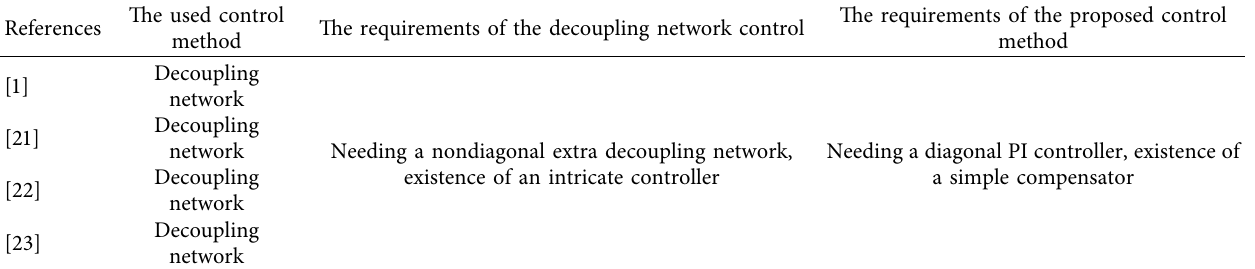
Table 2: Superiority of the proposed control method compared to the decoupling network technique.